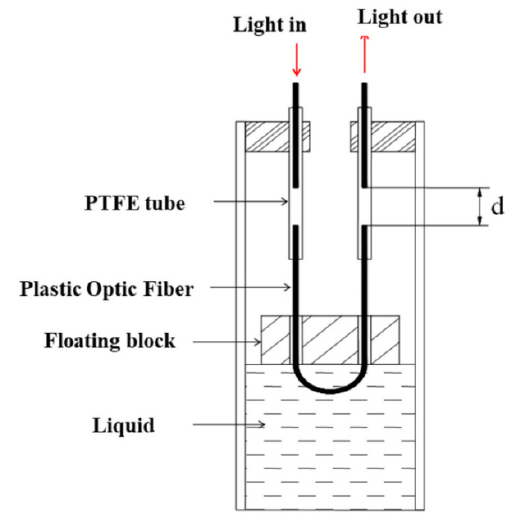
= polytetrafluoroethylene